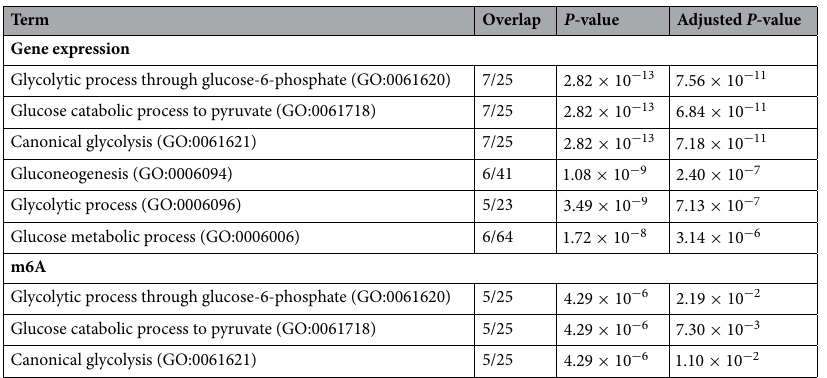
Table 8. “GO Biological Process 2018” category of Enrichr for 53 genes (based on gene expression) and 200 genes (based on m6A) selected by applying KTD-based unsupervised FE to integration of gene expression and m6A profiles. Nine glucose-related terms with adjusted P -values less than 0.05 are listed.